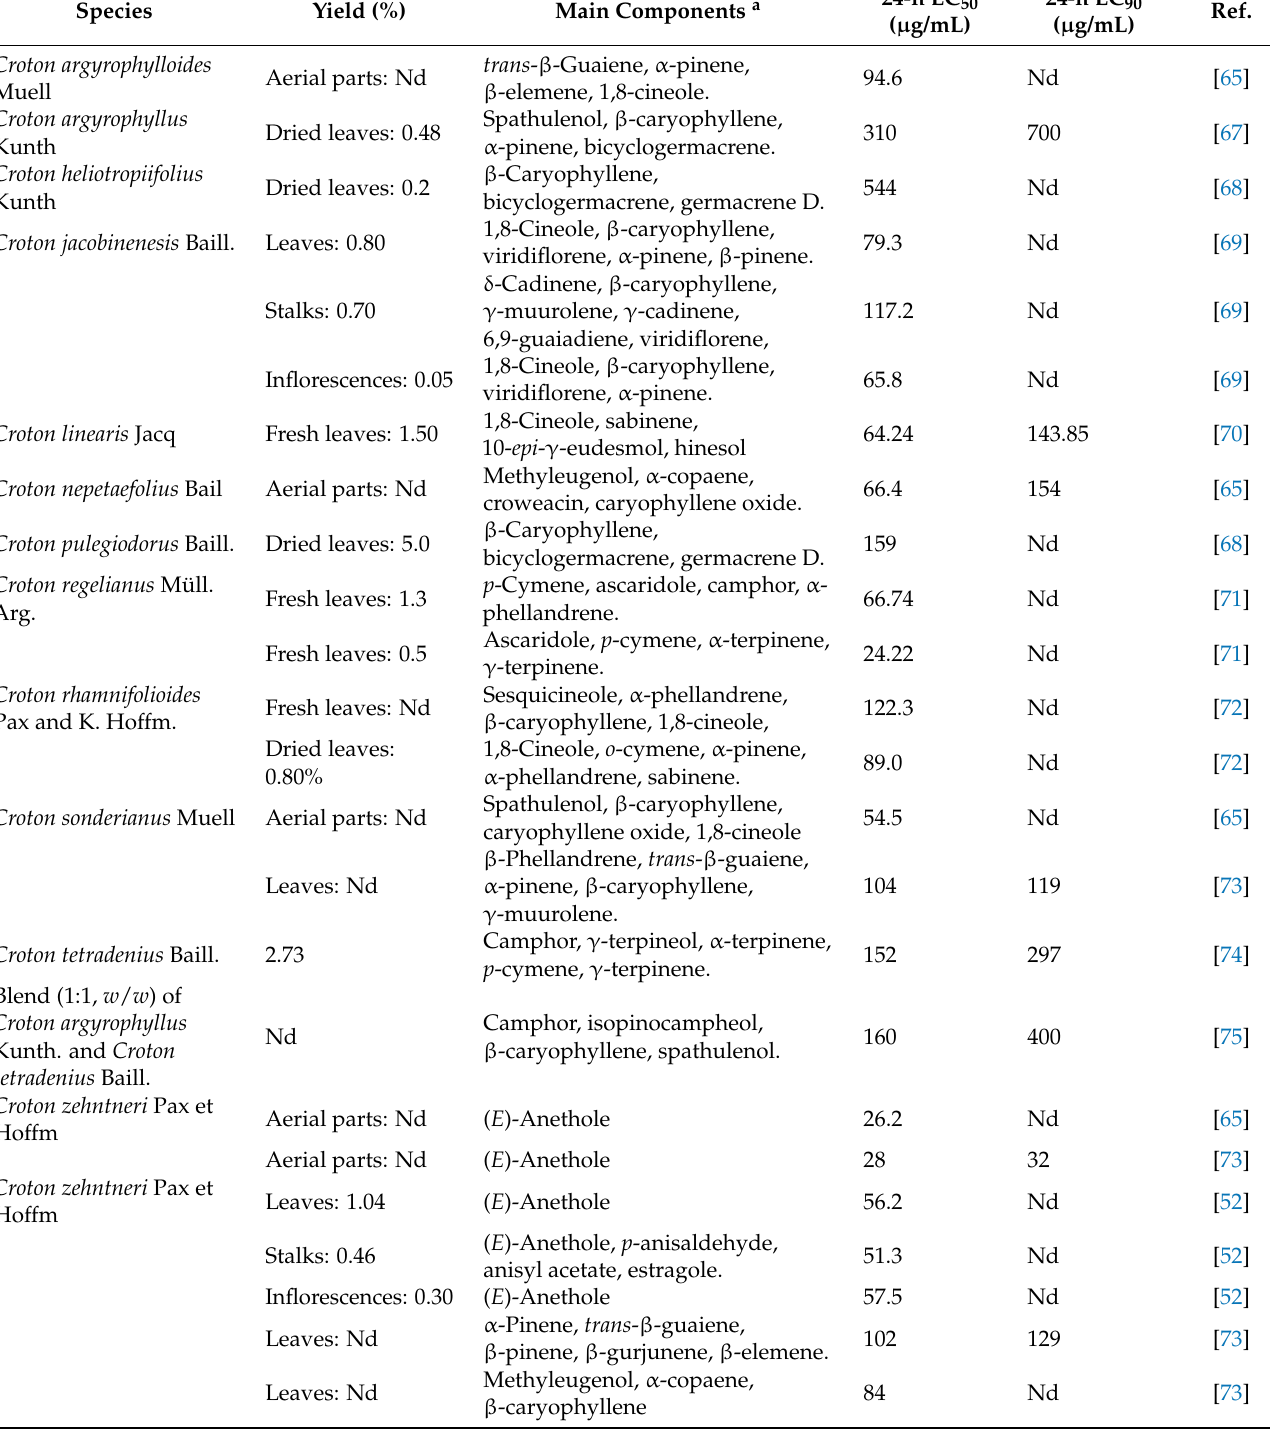
Table 4. Summary of Aedes aegypti larvicidal activity of essential oils of Croton